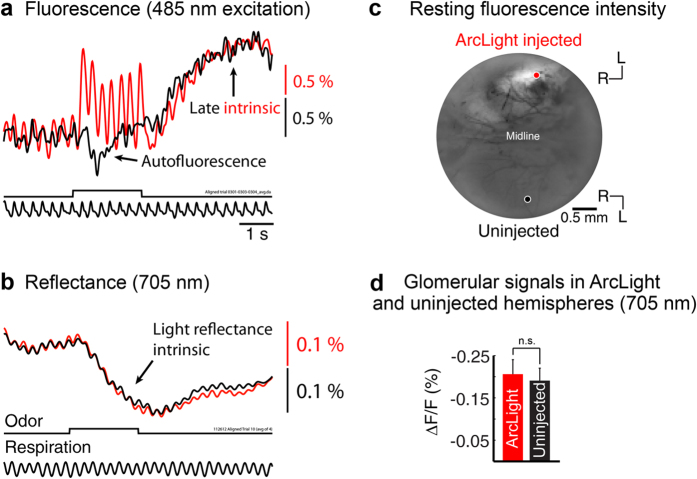
Time course of signals from ArcLight and uninjected hemispheres reveal that ArcLight signals are only present in the injected hemisphere, and the presence of ArcLight does not adversely affect intrinsic signals.(a) Measurements from injected (red trace) and uninjected hemispheres (black trace) using 485 nm excitation light and 530 long pass emission. The presumed slow intrinsic light scattering signal (slow upward) is present in both hemispheres, although the flavoprotein autofluorescence signal52 is only clearly seen in the uninjected hemisphere. The control trace is taken from an average of three respiration aligned trials. The odor and respiration traces are from a single trial. The traces are low-pass filtered at 4 Hz and inverted. (b) Comparison of intrinsic light reflectance signals measured using 705 nm light from the same locations in panel a. Traces are from an average of 4 respiration aligned trials, are low pass filtered at 2 Hz, and are shown in their original orientation. (c) Resting fluorescence intensity image of ArcLight injected (top) and uninjected (bottom) olfactory bulb hemispheres measured using 485 nm incident light. Overlaid kernels indicate the locations used for the traces shown in a and b. (d) Population statistics comparing glomerular responses measured with intrinsic light reflectance signals at 705 nm in ArcLight injected and uninjected hemispheres. The population comparison is non-significant (p > 0.05 using a 2-sample t-test). Data included in d are from averages of 2-6 trials.